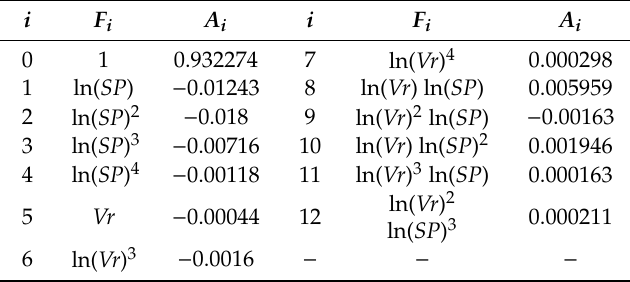
Table 1. Regressed coe ffi cients to be used in Equation (14)